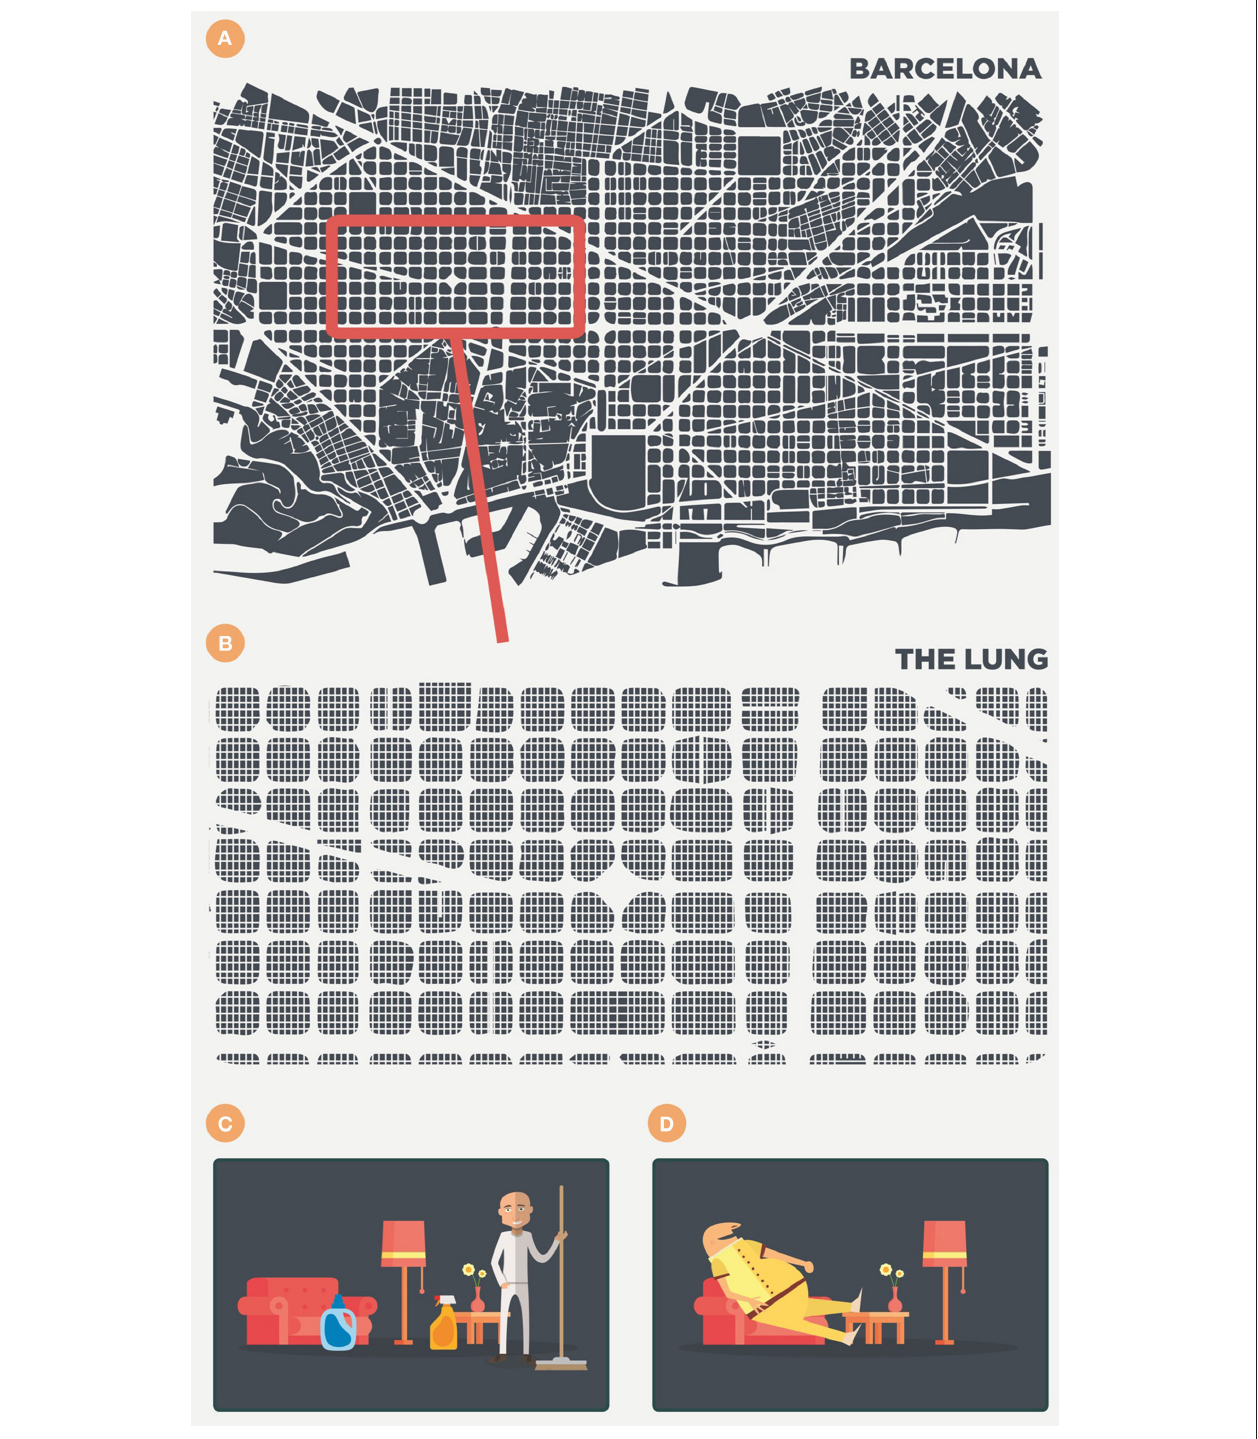
FIGURE 1 | Anthropomorphic view of the alveoli and the scenario in the lung. The lung is like a big city (i.e., Barcelona) of around 625km 2 , filled with 250 million of 25m 2 rooms (A,B) . Each room contains a cleaner—the alveolar macrophage (C) —that removes every particle that enters with the air every 6s. Finally, however, this cleaner becomes filled with lipid inclusions, forms a foamy macrophage, becomes useless and is finally drained out of the room (D) .